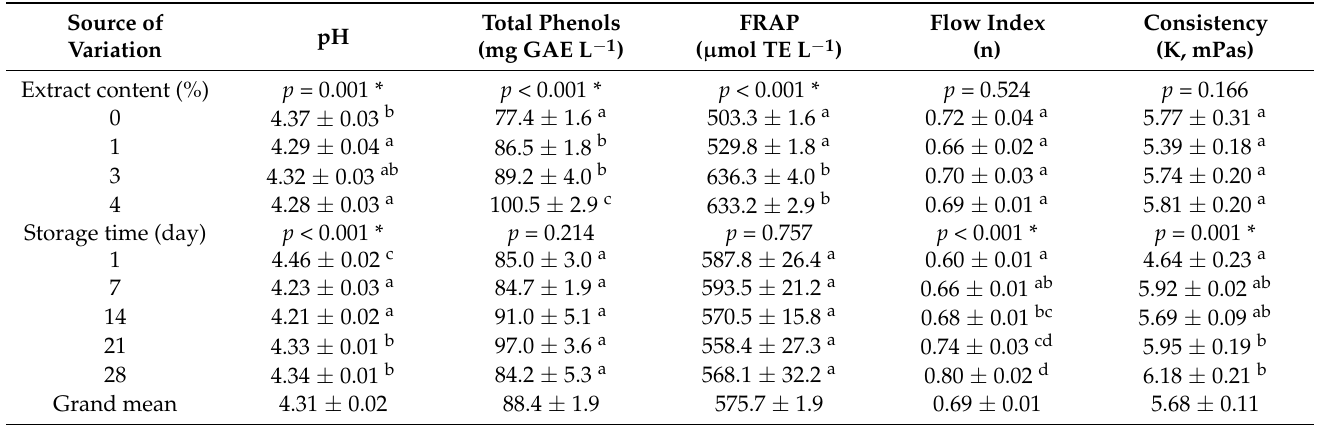
Table 2. Influence of extract content (0, 1, 3 and 4% ME) and storage time (1st, 7th, 14th, 21st and 28th day) on the physical and chemical characteristics of